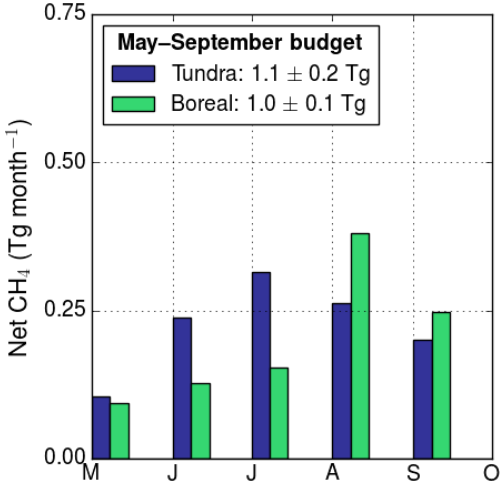
Figure 6. Estimated CH 4 emissions from tundra and boreal eco- regions averaged over all